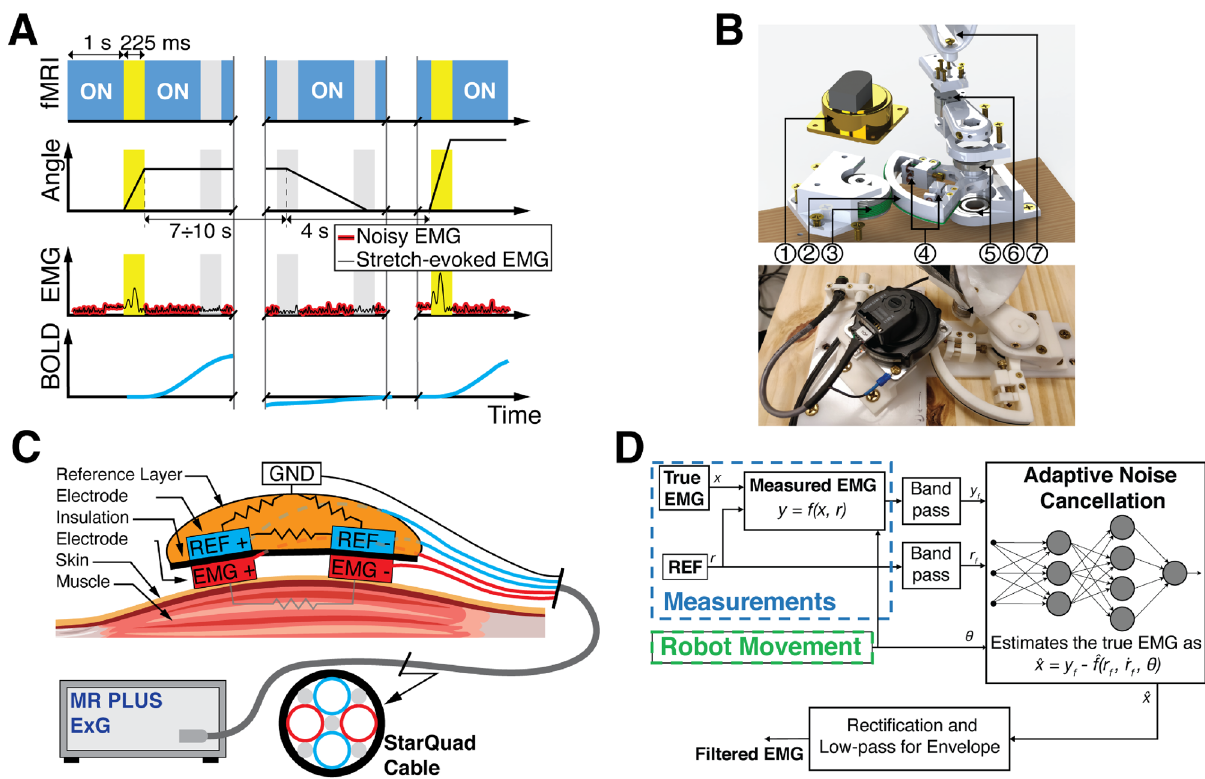
Figure 1. ( A ) Timing diagram of the MRI sequence (top row) with the 225 ms silent windows between acquisition of different volumes; (second row) commanded robot joint trajectory; (third row) expected EMG signal, which is clean during MRI silent windows; (bottom row) expected BOLD signal associated with the LLR; ( B ) Exploded view (top) and prototype (bottom) of the MR-StretchWrist. (1) Ultrasonic motor, (2) output capstan arc, (3) input pulley, (4) tensioning mechanisms, (5) structural bearings, (6) force/torque sensor, (7) hand support; ( C ) Hardware of the novel apparatus developed for the acquisition of the EMG data during fMRI protocols ( D ) EMG processing scheme based on Adaptive Noise Cancellation ( schemes for the other processing pipelines used for this work are reported in Fig. S7). ( A ) and ( B ) are modified from 29